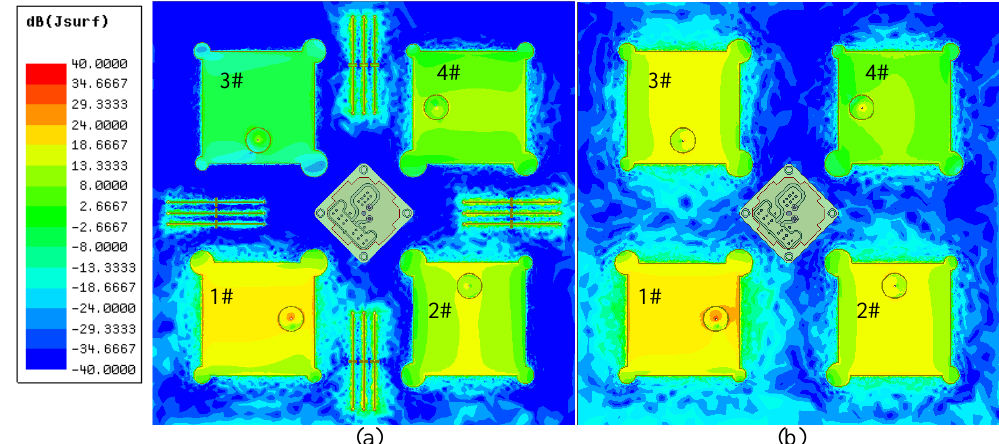
Figure 9. Surface current distribution of the array ( a ) with and ( b ) without isolation